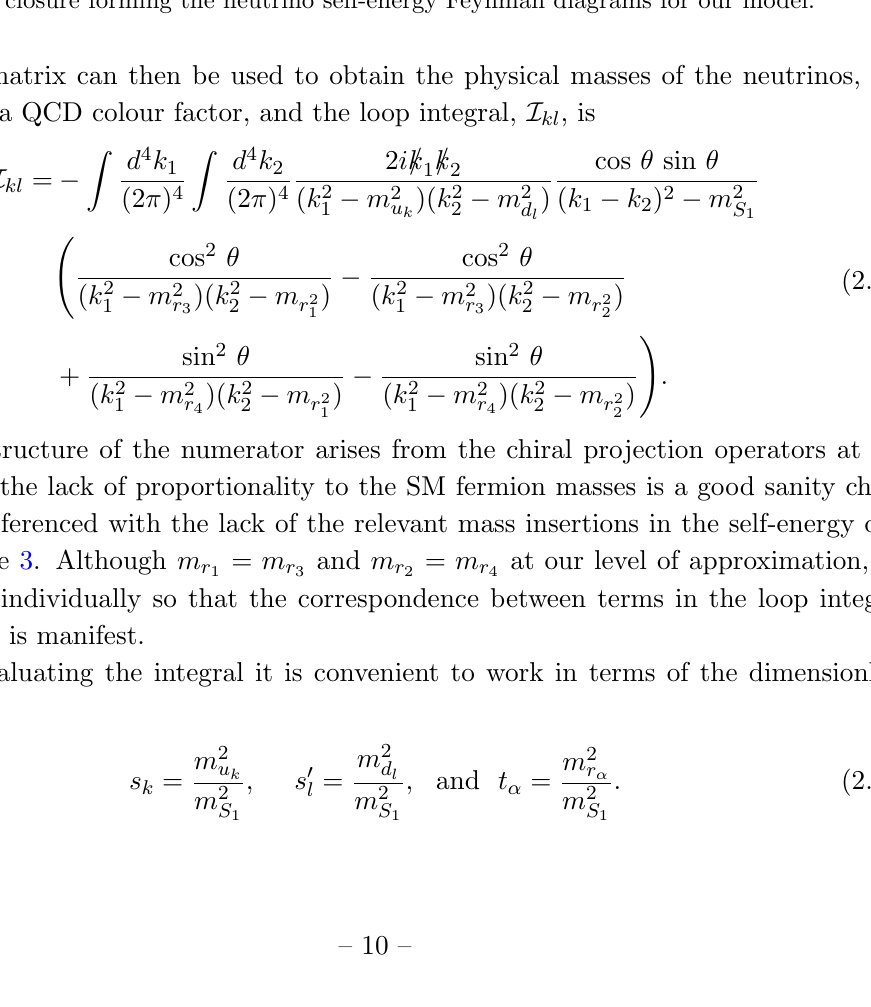
Figure 3 . The UV-completion of operator O 47 by the exotic scalars S 3 (leptoquark), S 1 (diquark) and (cid:30) 3 and its closure forming the neutrino self-energy Feynman diagrams for our